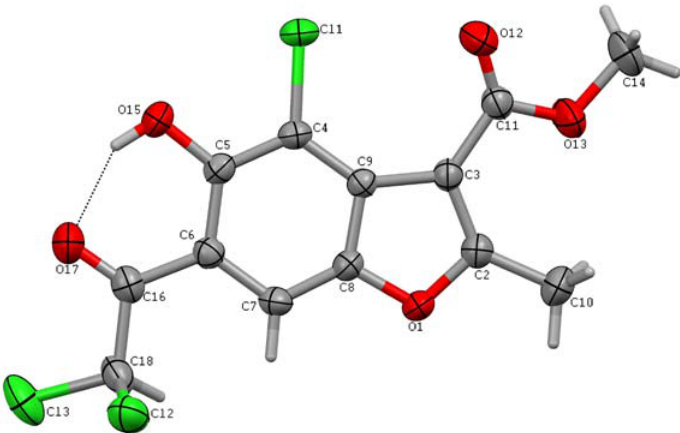
Figure 6. A view of the molecule of VI .